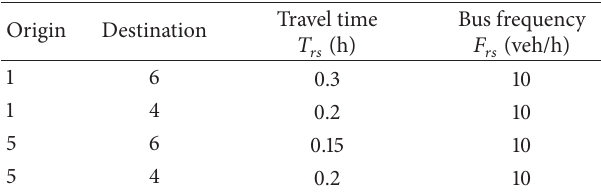
Table 2: Bus travel time and frequency.